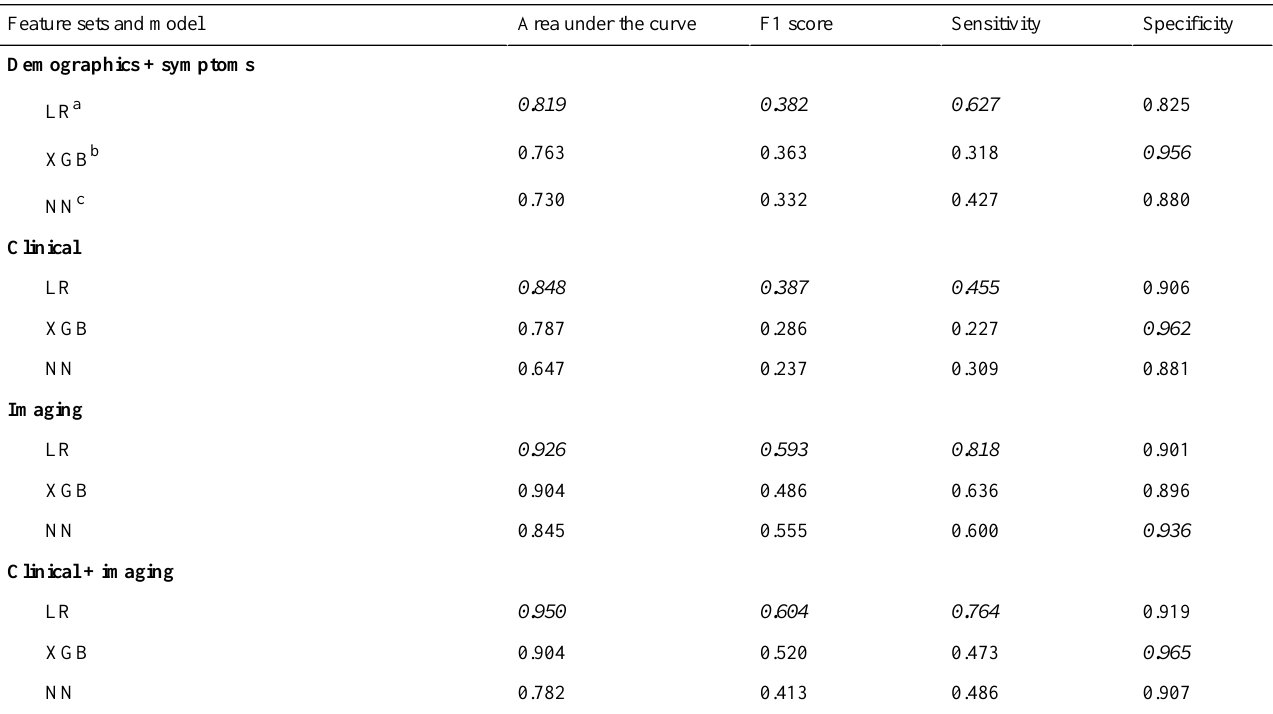
Table 3. Results of using different feature sets (values in italics indicate the best results).